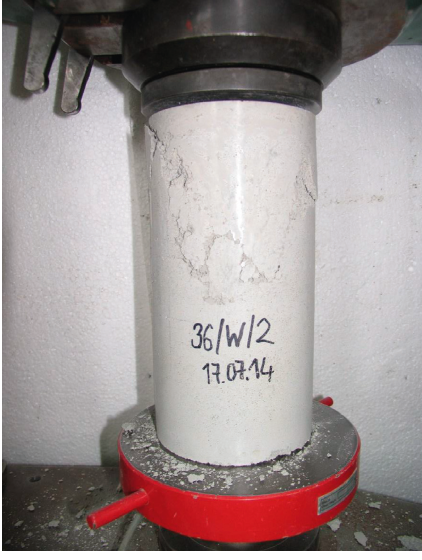
Figure 4: Typical failure pattern observed during compression tests with cylindrical